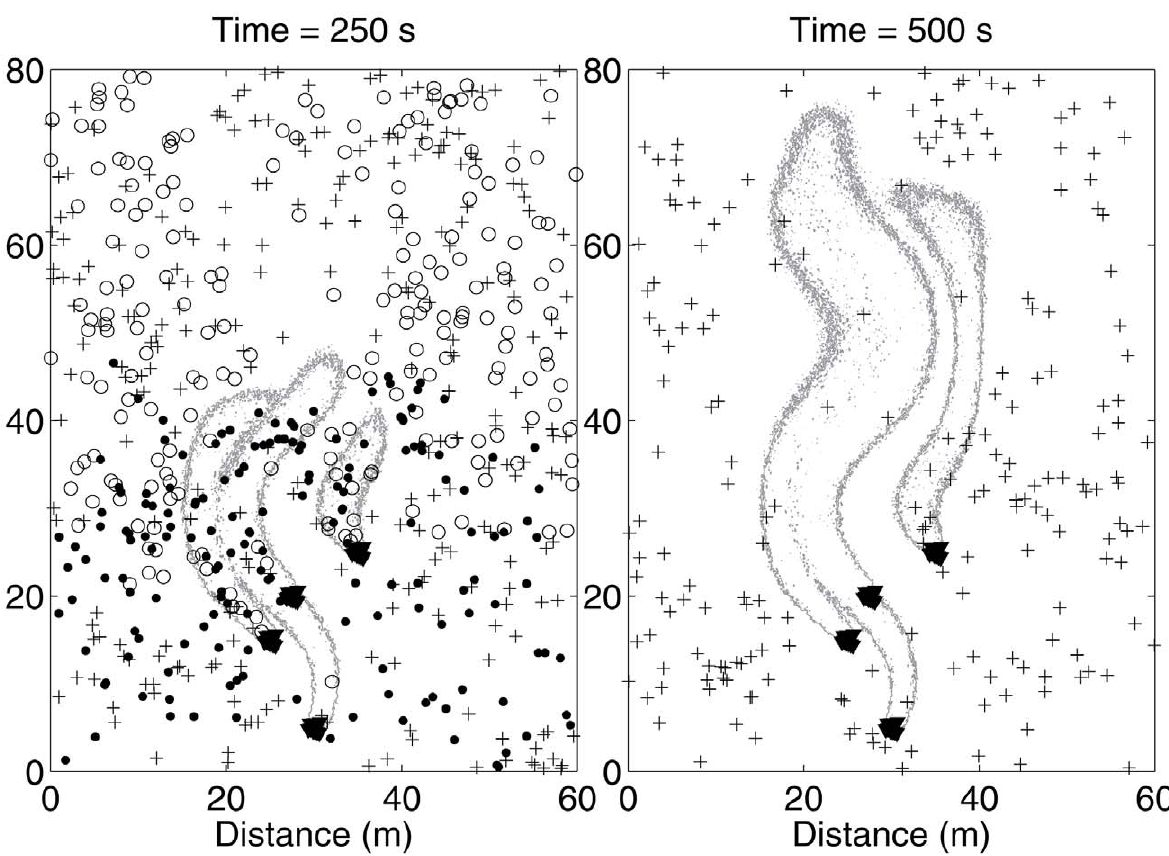
Figure 8. Growing odor plume in a large domain. Mosquitoes of all three plume-finding behaviors ( : upwind, 0 downwind, z crosswind) near an evolving plume about 45–70 m long. All distances are in meters and only the outermost contour of the plume is shown. Left: The plume after 250 s. The upwind and downwind mosquitoes are already segregating into the upwind and downwind sides of the domain. Right: The same part of the domain after 500 s. The plume is about 2/3 longer and only crosswind mosquitoes remain in the vicinity of the